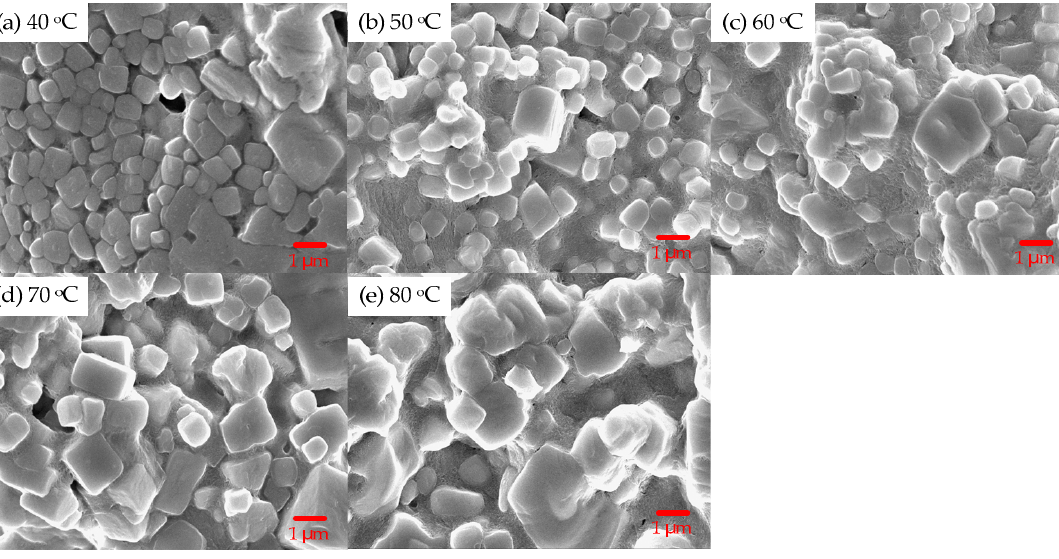
Figure 3. Scanning electron microscopy (SEM) images of the MAPbBr 3 crystals growth temperature at ( a ) 40 °C, ( b ) 50 °C, ( c ) 60 °C, ( d ) 70 °C, and ( e ) 80 °C.